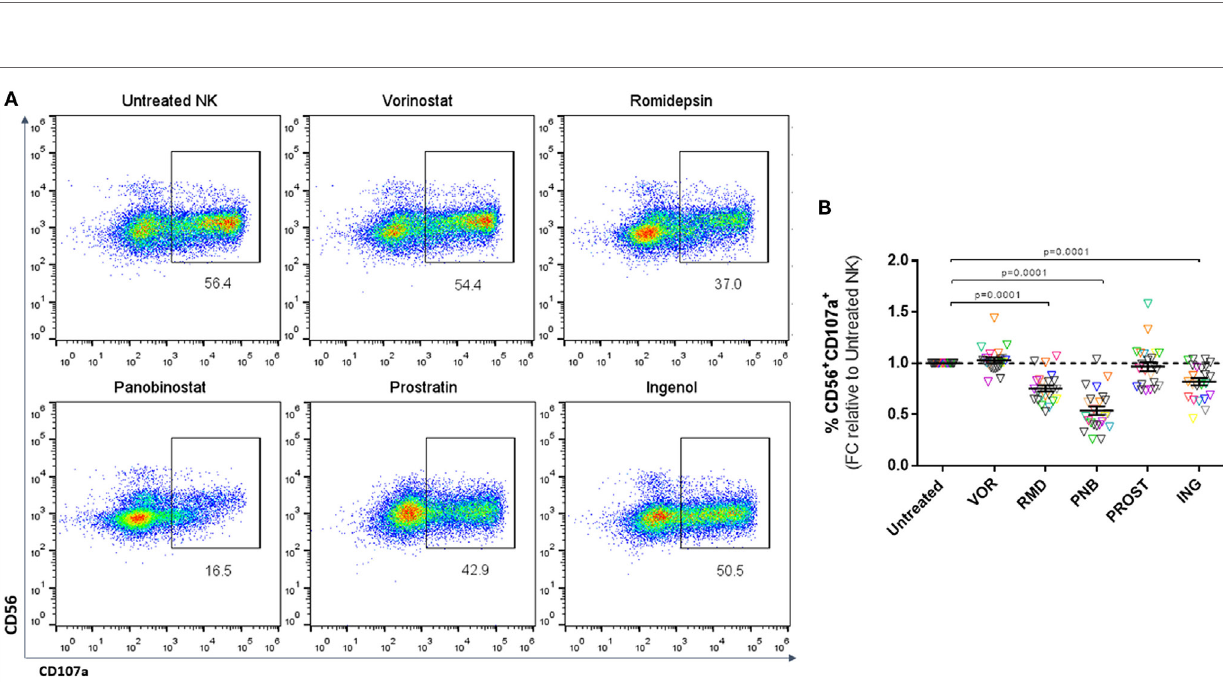
FigUre 3 | cytotoxicity of nK cells . Proportion of CD56 + CD107a + cells after 4–6 h culture with K562 cells, expressed as fold change (FC) relative to untreated NK cells. (a) Representative FACS analysis plots showing the gating strategy. (B) Proportion of CD56 + cells expressing the degranulation marker CD107a. Each color represents cells from a different donor. Exposure to PNB, RMD and ING significantly impaired NK degranulation. N = 23.